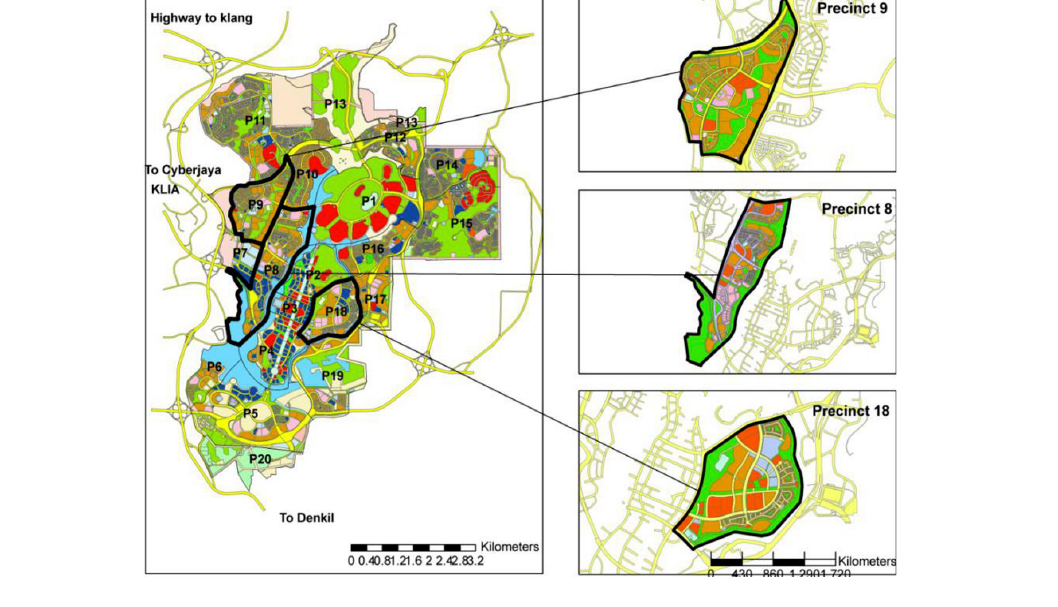
FIG. 1. STUDY AREAS (SOURCE: GIS UNIT PERBADANAN